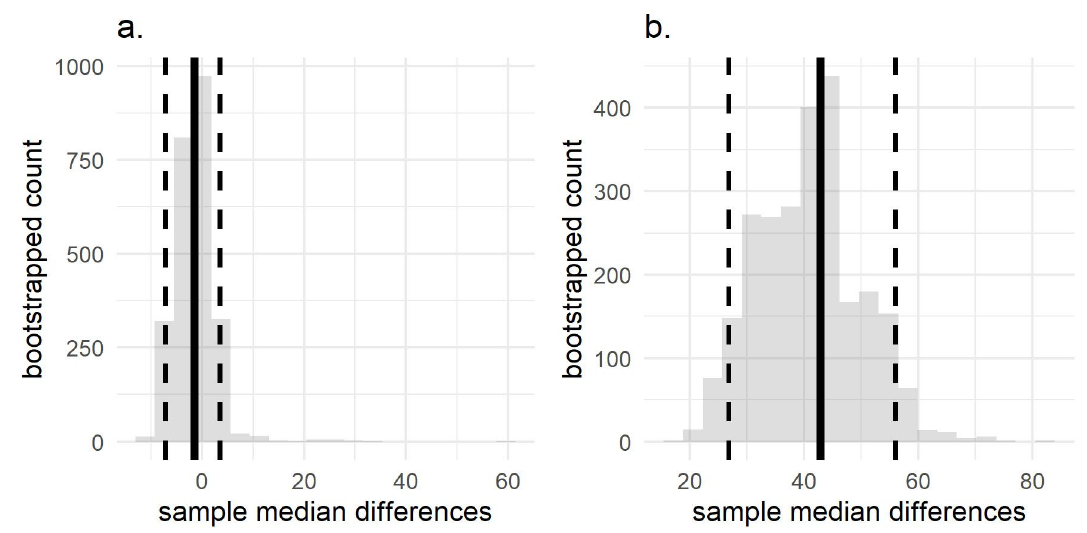
Figure 6. Results of the two-sample bootstrap to compare the median differences between ( a ) golf courses and airports and ( b ) golf courses and parks based on median percentage of land feature burned.